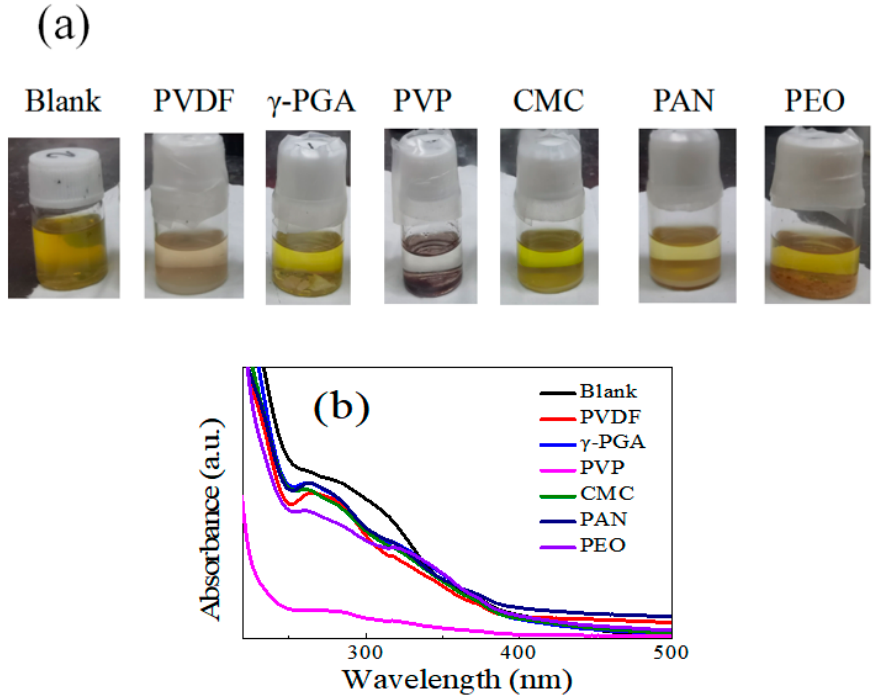
Figure 2. ( a ) Photographs of the Li 2 S 6 solution with PVDF, γ -PGA, PVP, CMC, PAN, and PEO and ( b ) UV-vis spectra of the corresponding solutions.